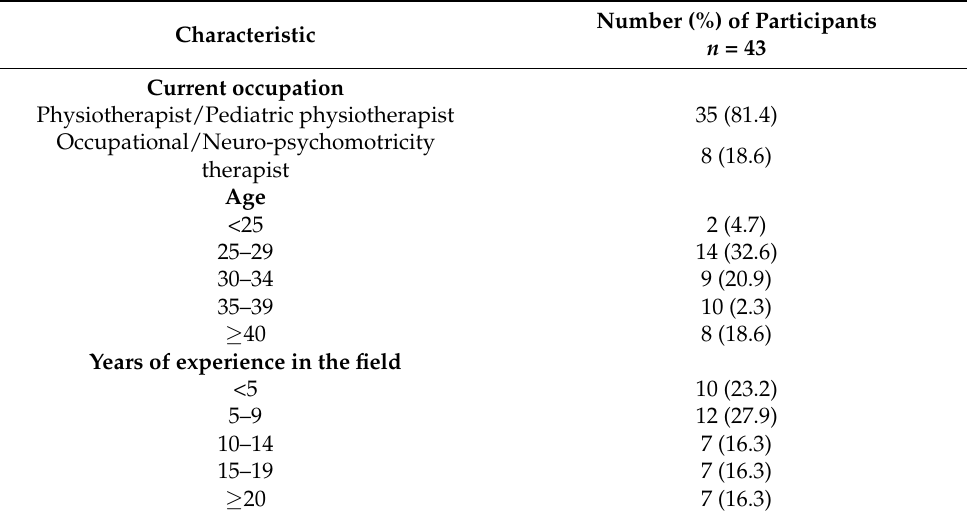
Table 1. Demographic characteristics of the participants, including current occupation, age, and years of experience in the field ( n = total number of participants).